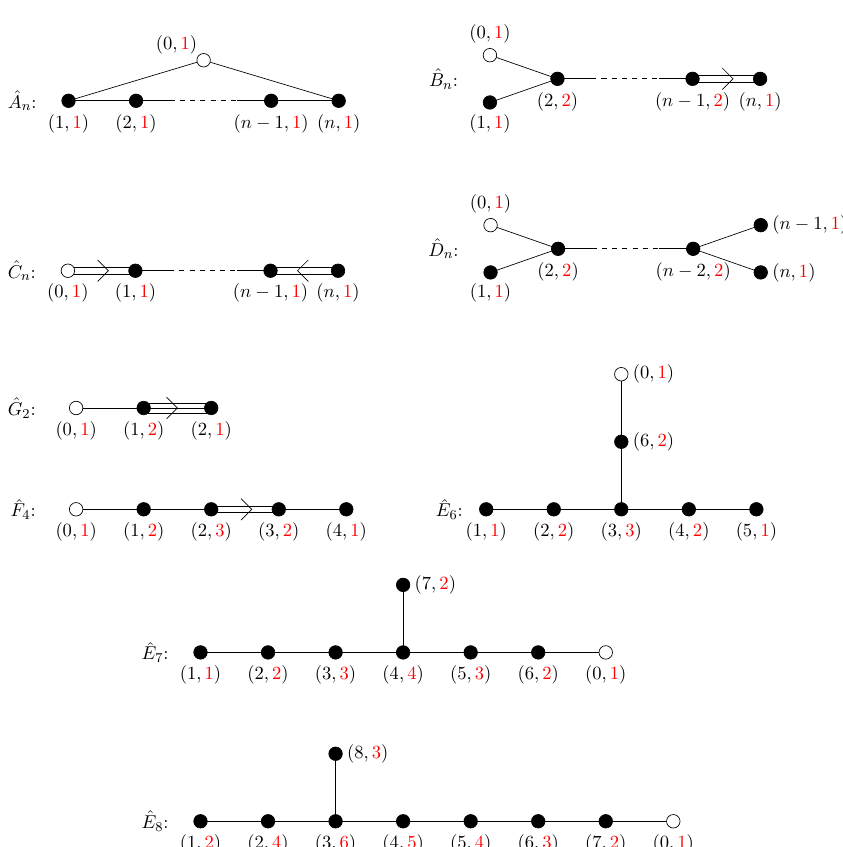
Figure 4 . Affine Dynkin diagrams associated to simple Lie algebras. The i -th node with comark m i is labeled by the pair ( i, m i ) where the number m i is colored in red. In each diagram, the white node is the affine node, and the black nodes are nodes of simple Lie algebra. The arrows point from short coroots to long coroots. We follow the same node order and same representation names as in the LieART package [116, 117] of Mathematica